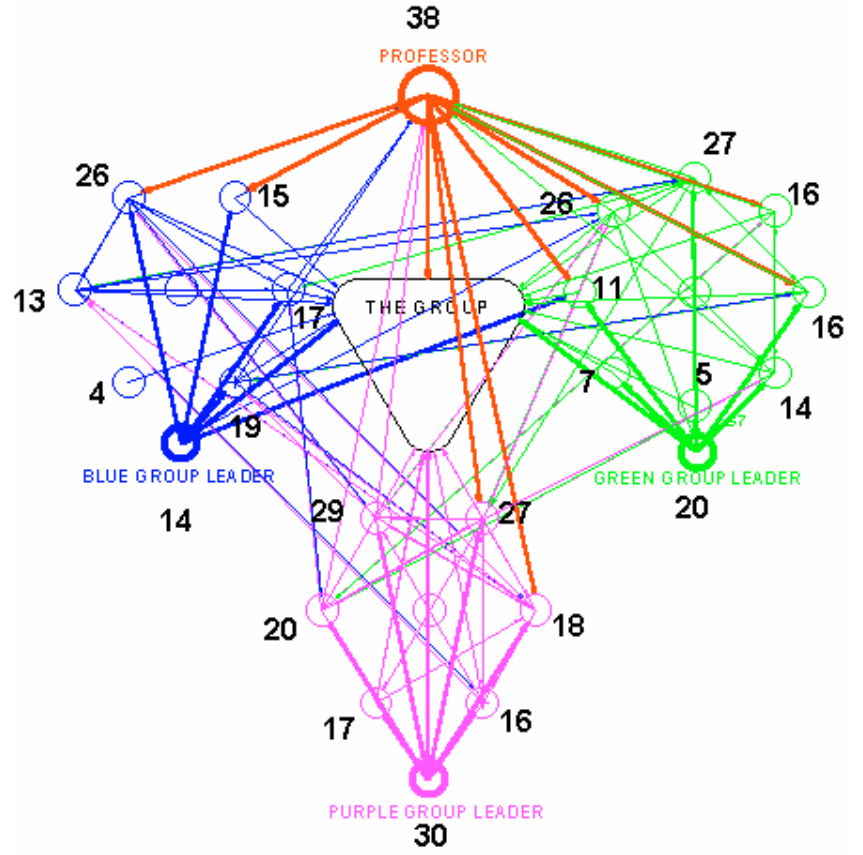
Figure 5. One hour Interaction Diagram of October 10, 2001 eClass, colour coded to the small breakout group identities. The bold numbers are the total messages sent by the participant during this time